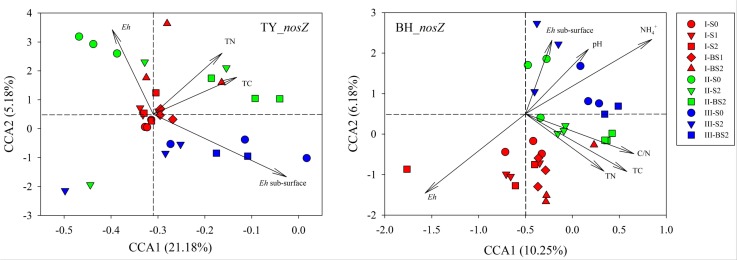
Canonical correlation analysis for the nosZ gene containing denitrifier communities and soil properties. Three rice growth stages, seedling, tillering and heading, were included and labeled as I (red), II (green) and III (blue), respectively.